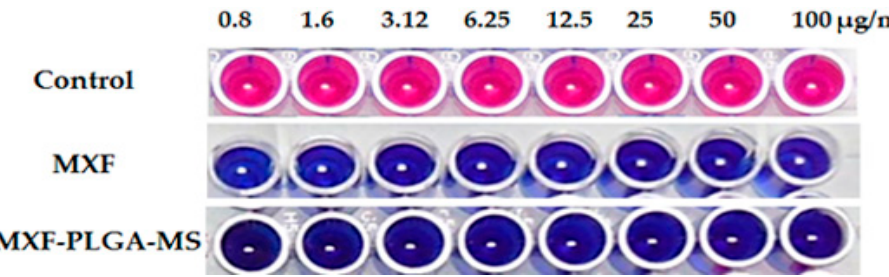
Figure 5. Anti-tubercular activity of free moxifloxacin and MXF-PLGA-MS.